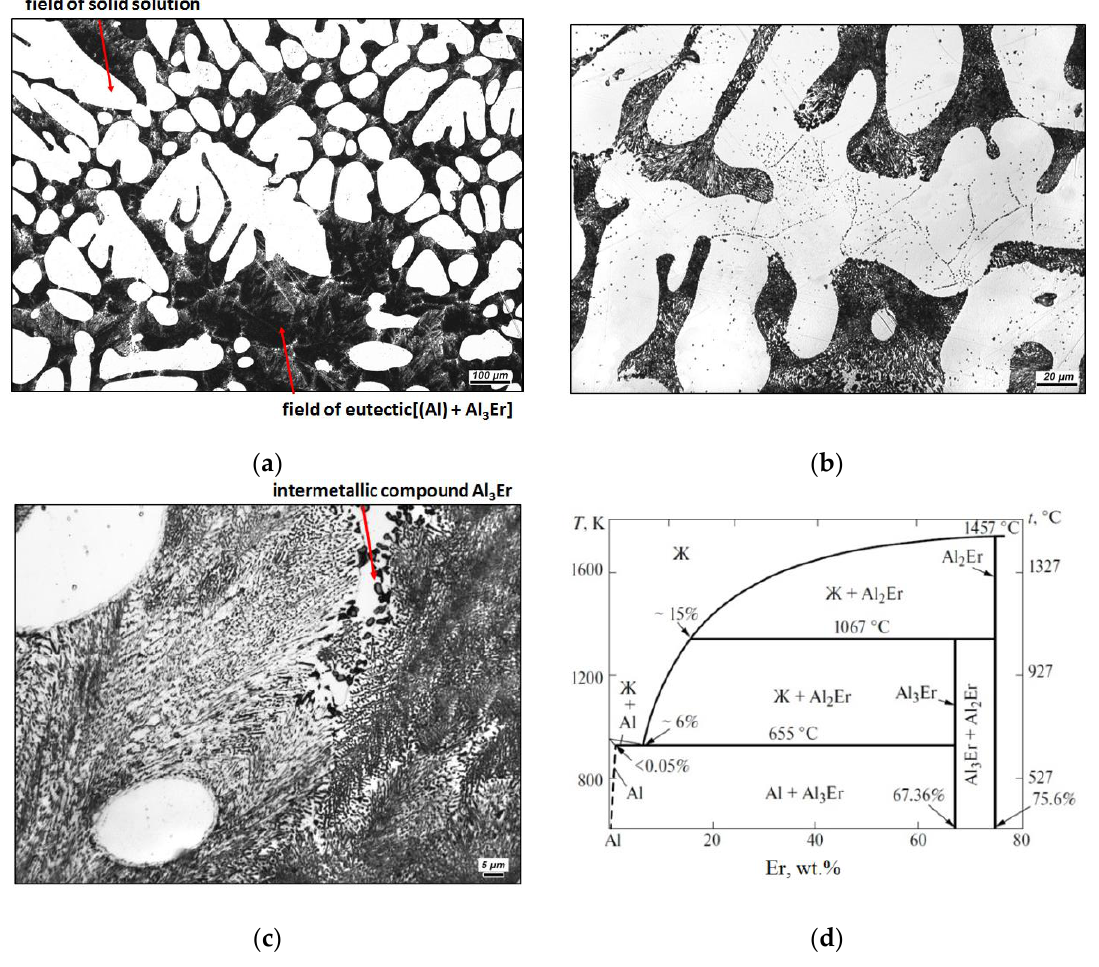
Figure 2. Typical images of microstructures of aluminum-erbium master alloys: ( a ) × 100; ( b ) × 500; ( c ) × 1000; ( d ) Analysis of equilibrium phase